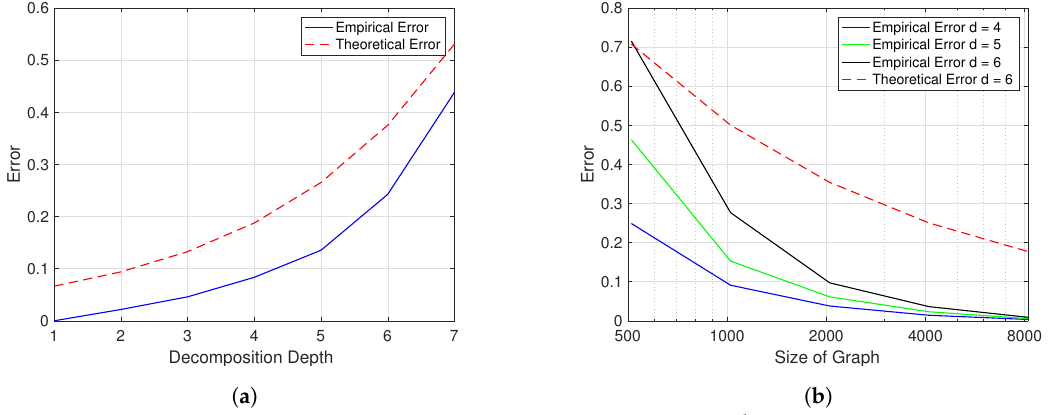
Figure 4. ( a ) Approximation quality of the graph spectrum for the family depths of the hierarchical decomposition. ( b ) Approximation quality of the graph spectrum for the family l , with decomposition depth d = 1/2 S